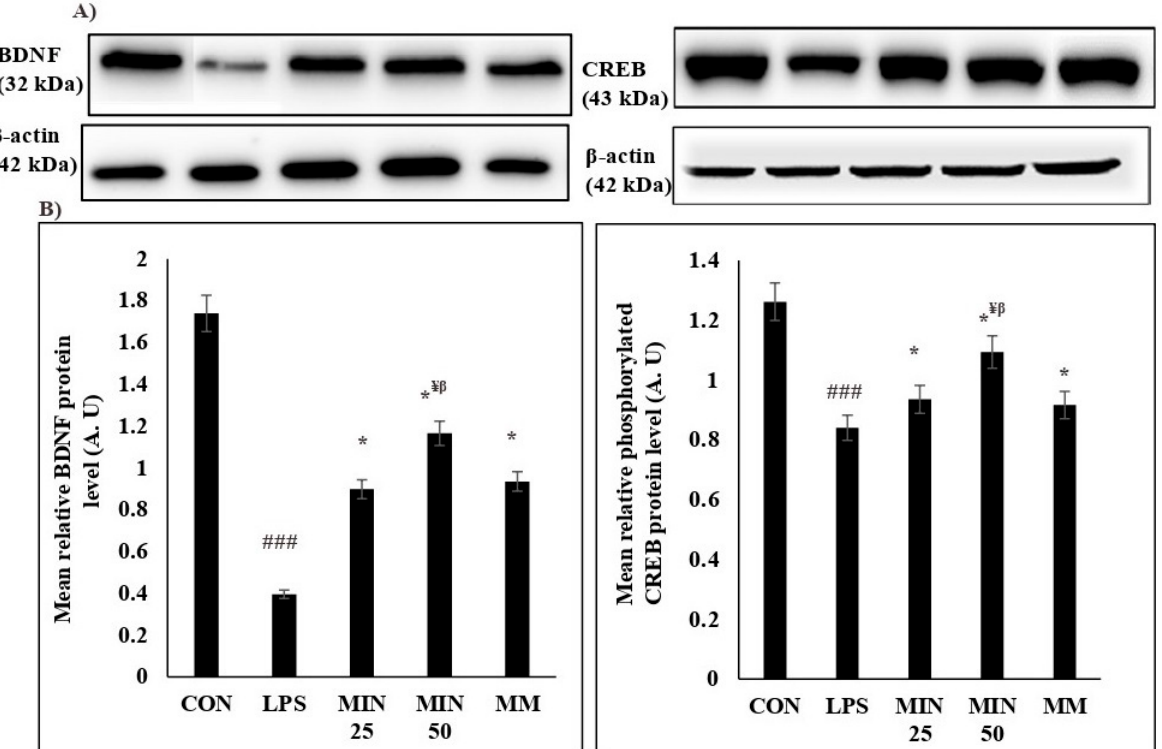
Figure 4. Effects of minocycline on the mean relative of BDNF and phosphorylated CREB protein levels in the mPFC. An example of Western blot results for all groups ( A ). The lower panel demonstrates the loading control. ( B ) Quantification analysis of IDV between the groups. The data were normalised by the control group. One-way ANOVA test followed by Bonferroni post hoc test. Values are expressed as mean ± SEM. n = 10. (F (1, 36) = 50.30; ### p < 0.001) versus control group; (F (1, 36) = 11.38; * p < 0.05) versus LPS group, (F (1, 36) = 9.38; ¥ p < 0.05) versus MIN 25, (F (1, 36) = 7.86; β p < 0.05) versus MM.